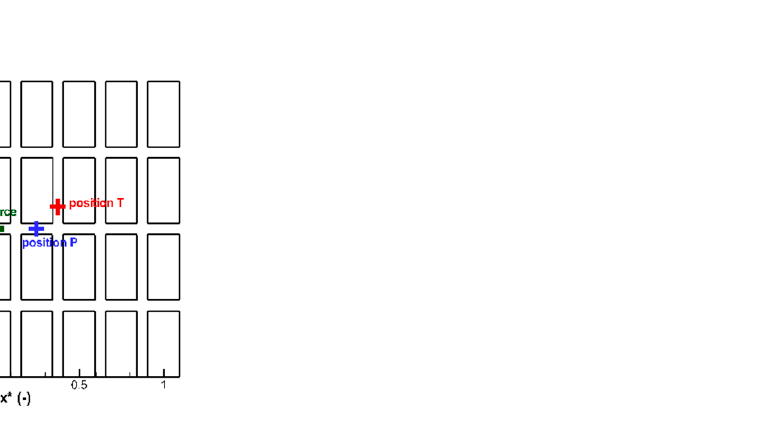
Figure 2. Layout of the model with the sampling positions (position P, T) and the gas source position represented by the crosses. The arrow direction is the direction of the main flow.